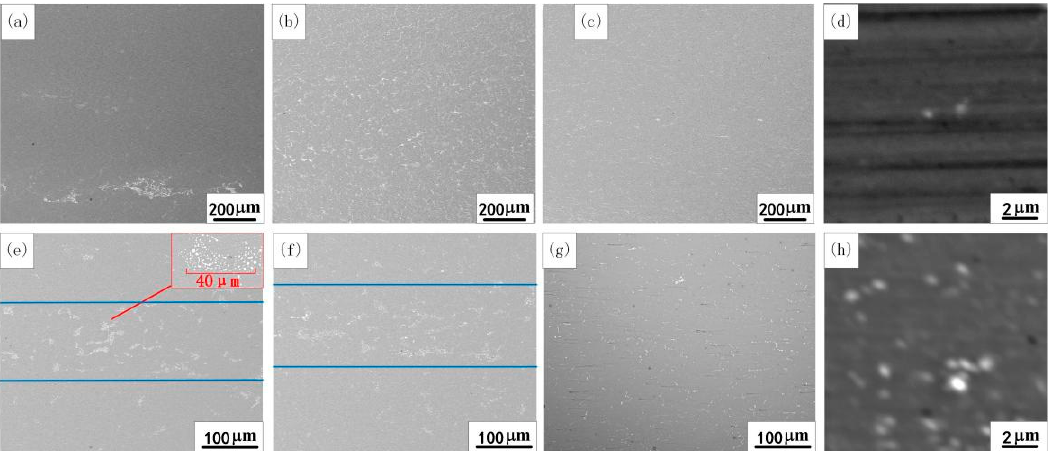
Figure 4. SEM results of ACMZ alloy with different content of nanoparticles after as-cast and isothermal holding + solid solution (IS) treatment. ( a ) ACMZ, as-cast; ( b ) ACMZ-0.1 nanoparticles, as- cast; ( c ) ACMZ-0.3 nanoparticles, as cast; ( d ) T phases in ACMZ, isothermal holding; ( e ) ACMZ, IS; ( f ) ACMZ-0.1 nanoparticles, IS; ( g ) ACMZ-0.3 nanoparticles, IS; ( h ) T phases in ACMZ-0.3 nanoparticles, isothermal holding.